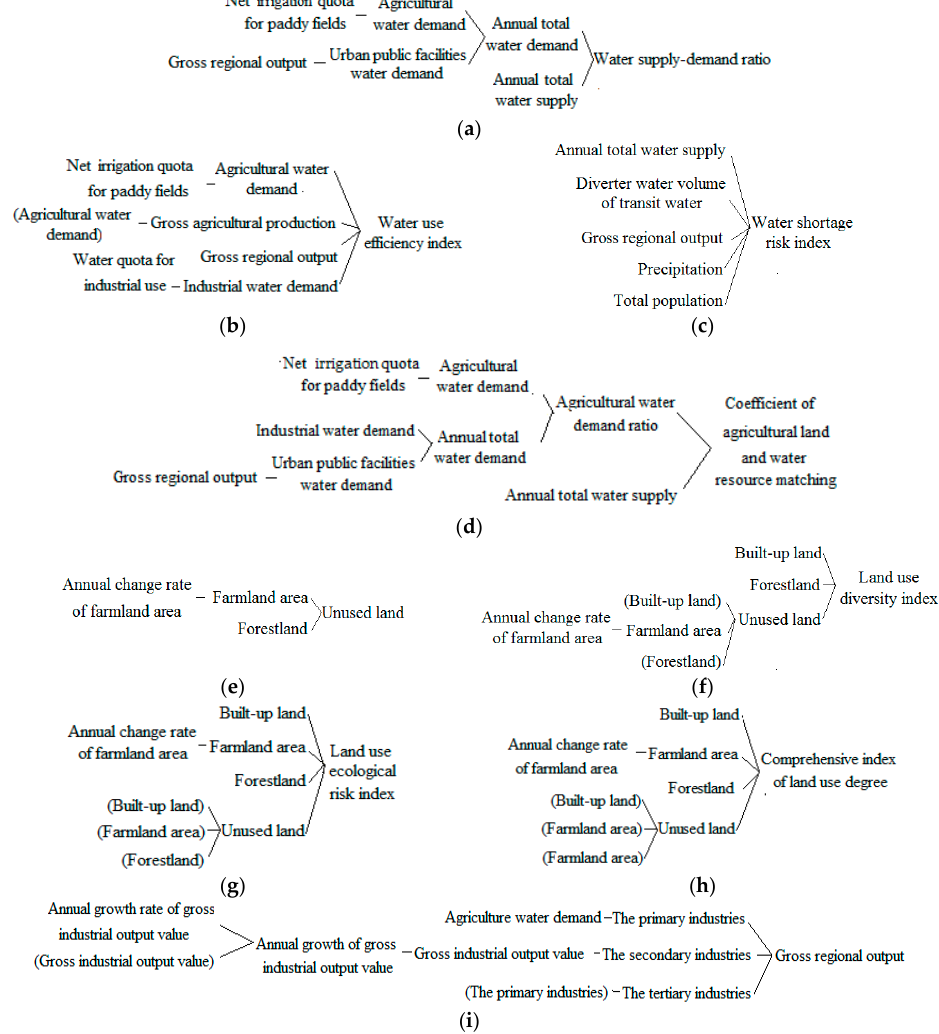
Figure 9. The characteristic variable tree. ( a ) Water supply-demand ratio variable tree; ( b ) Water use efficiency index variable tree; ( c ) Water shortage risk index variable tree; ( d ) Coefficient of agricultural land and water resource matching variable tree; ( e ) Unused land variable tree; ( f ) Land use diversity variable tree; ( g ) Land use ecological risk index variable tree; ( h ) Comprehensive index of land use degree variable tree; ( i ) Gross regional output variable tree.